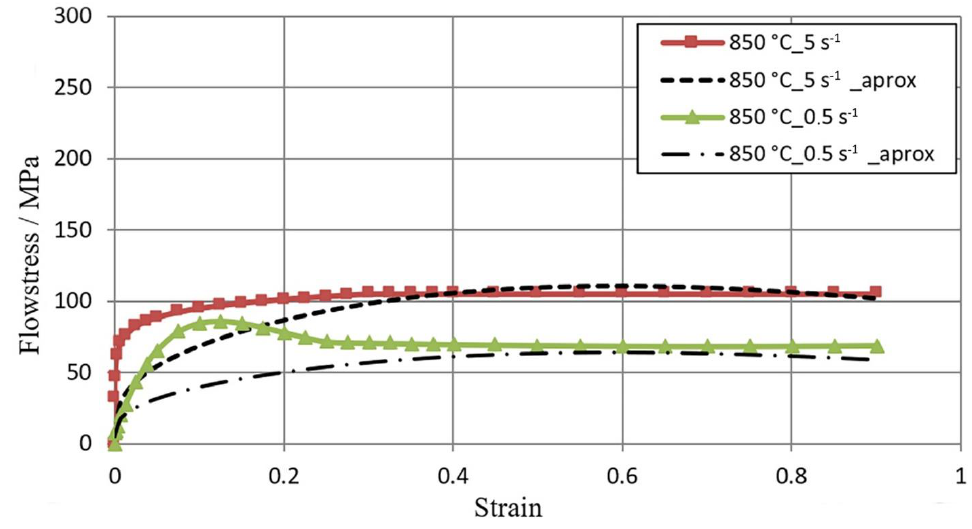
Figure 6. σ p − ε M5 alloy flow curves obtained for the temperature T = 850 ◦ C in the range of ´ ε Figure 6. σ p − Ɛ M5 alloy flow curves obtained for the temperature T = 850 °С in the range of έ strain strain rate from 0.5 to 5.0 s − 1 using the Gleeble metallurgical process simulator 3800; (1) continuous rate from 0.5 to 5.0 s −1 using the Gleeble metallurgical process simulator 3800; (1) continuous lines — lines—experimental data; (2) dashed lines—data after approximation. experimental data; (2) dashed lines — data after approximation.